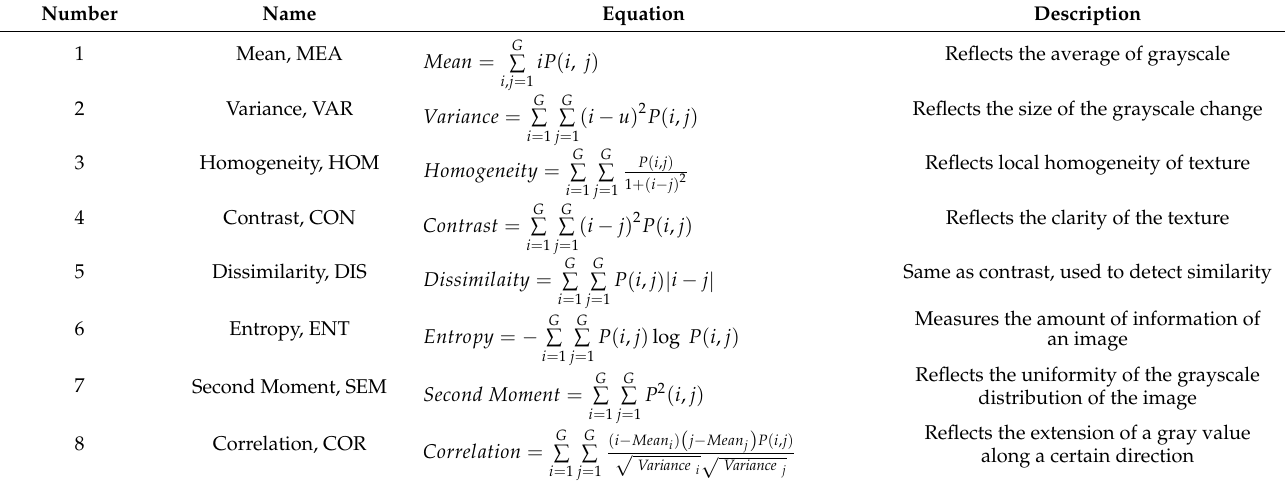
Table 1. Texture features based on gray-level co-occurrence